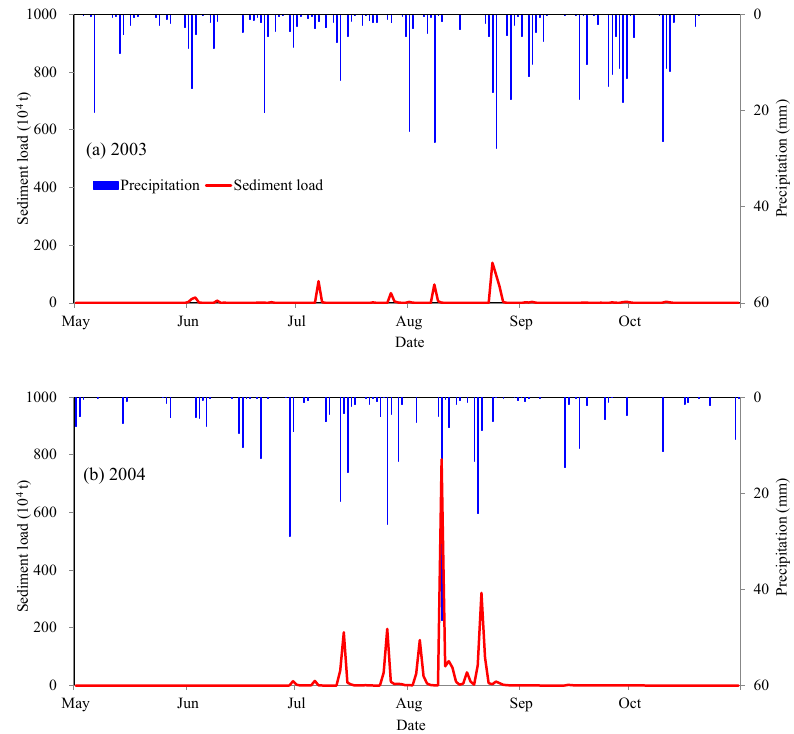
Figure 11. Daily precipitation and sediment load of the Yanhe catchment during the rainy season (May–October) in (a) 2003 and (b) 2004. Table 6. Pearson correlation coefficients ( r ) and two-tailed significance test values ( p ) between sediment yield and annual precipitation ( P ), number of storms ( N storm ) , and precipitation amount of storms ( P storm ) during different decades of the CSHC region. Decades P N storm P storm r p r p p 1960s 0.015